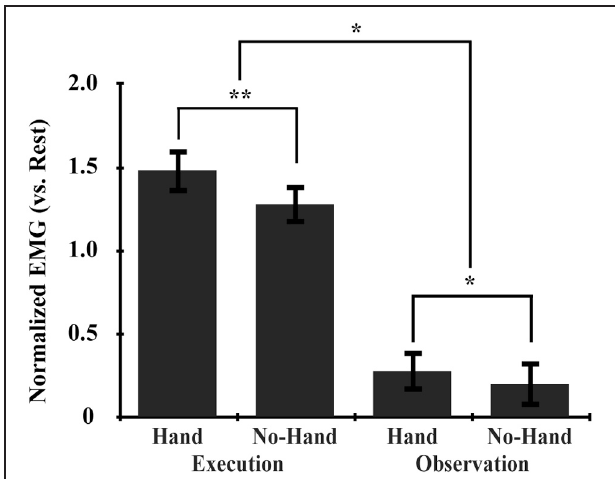
FIGURE 3 | EMG data. The normalized EMG value was calculated by subtracting that during the rest condition from that during the task. Asterisks indicate significant differences between conditions with three-way rmANOVA ( ∗∗ p < 0 . 001; ∗ p < 0 . 01). All error bars indicate the standard error of the mean